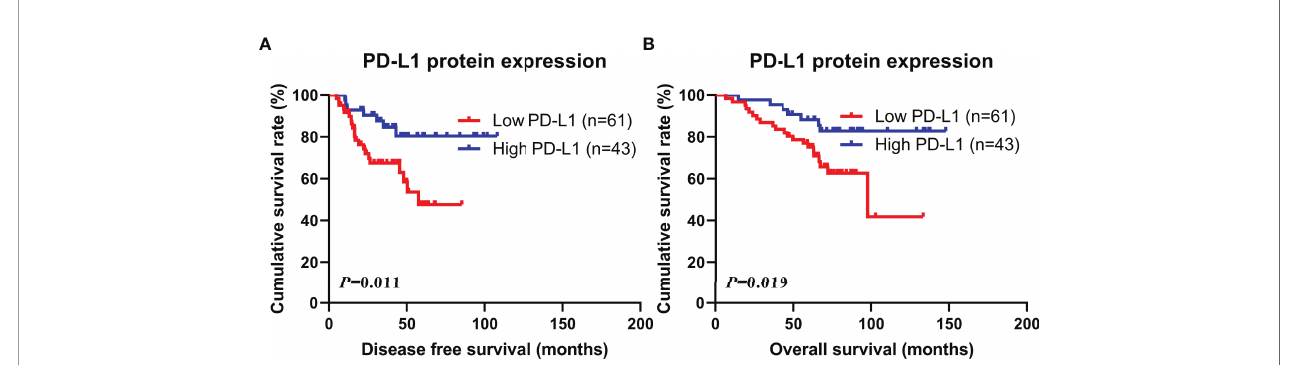
FIGURE 1 | Kaplan-Meier curves for disease free survival (DFS) and overall survival (OS). (A) Kaplan-Meier curves for DFS for PD-L1 protein expression in tumor cells; (B) Kaplan-Meier curves for OS for PD-L1 protein expression in tumor